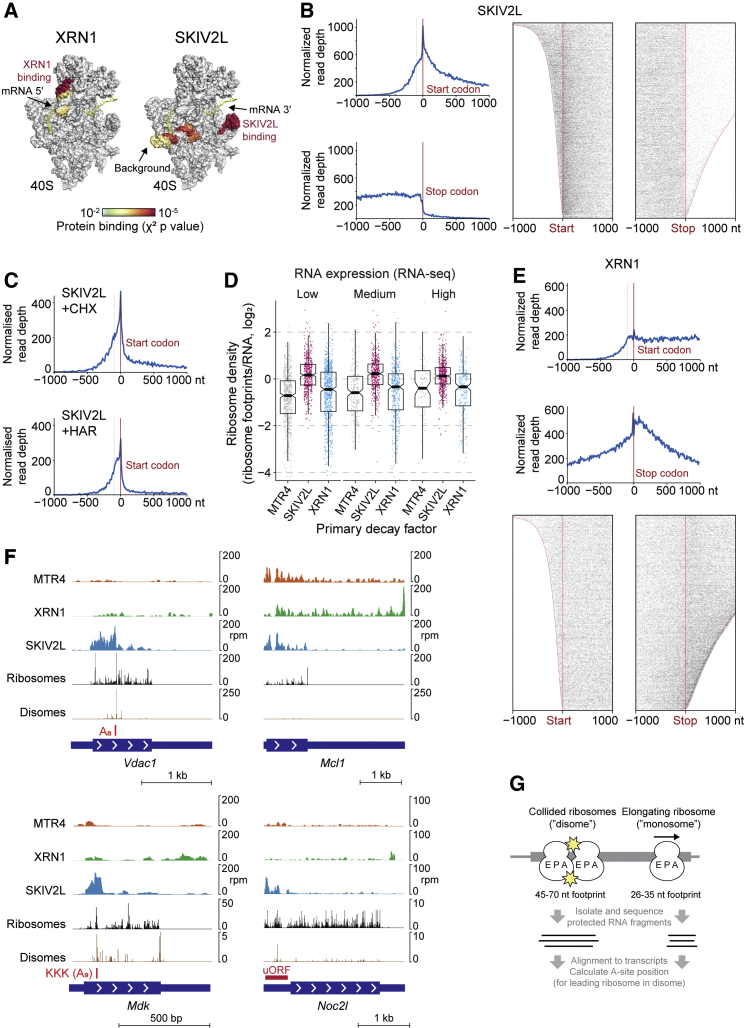
Cytoplasmic mRNA Decay Is Widely Influenced by Translation(A) CRAC signal for SKIV2L and XRN1 on the ribosomal 40S subunit, based on the mouse rRNA sequence and human structure (Khatter et al., 2015). Significantly bound regions are colored by χ2 p value, and the mRNA path (yellow) is taken from Schmidt et al. (2016).(B and C) CRAC signal for SKIV2L around start and stop codons, summed (left) or for individual mRNAs (right). Data in (B) correspond to untreated cells, whereas those in (C) correspond to 30-min cycloheximide or harringtonine treatment.(D) Ribosome densities for mRNAs grouped by expression and most abundantly bound decay factor (defined in Figure 1E).(E) XRN1 CRAC signal around start and stop codons.(F) CRAC, monosome, and disome profiling for individual mRNAs.(G) Monosome and disome profiling approach.See also Figure S2 and Table S4.